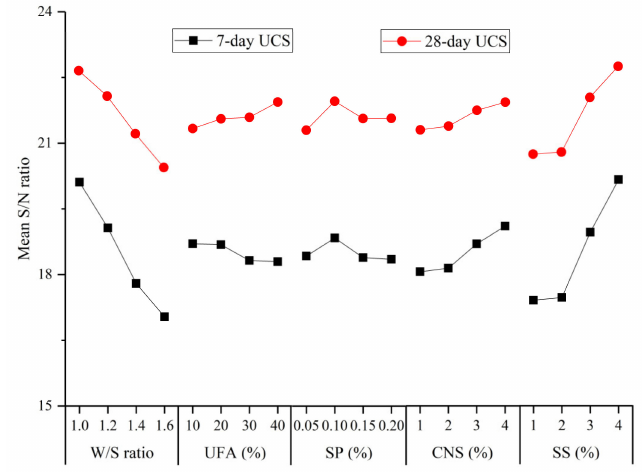
Figure 13. Mean S/N ratio values of the 7-day and 28-day UCS of the hardened UC-based slurries for different